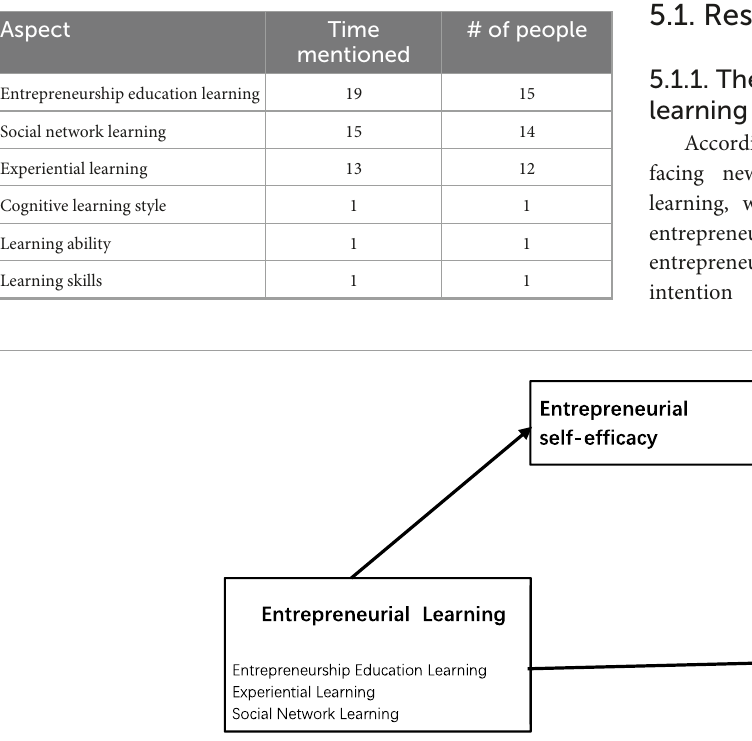
FIGURE1 Theoretical